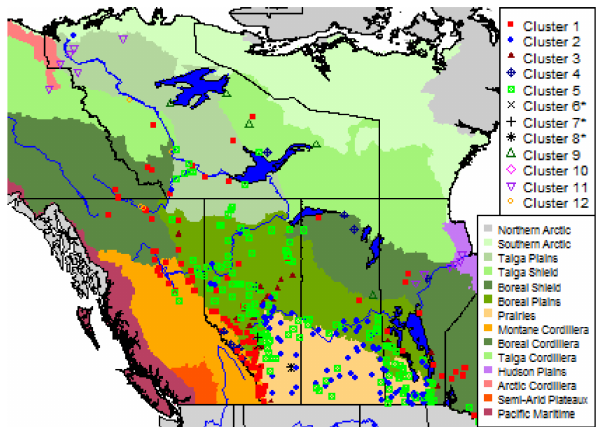
Figure 7. Locations of the 12 Streamflow Regime Types from the changing cold-region domain overlain on the ecosystems of West- ern Canada. Clusters marked with an ∗ have only a single member.